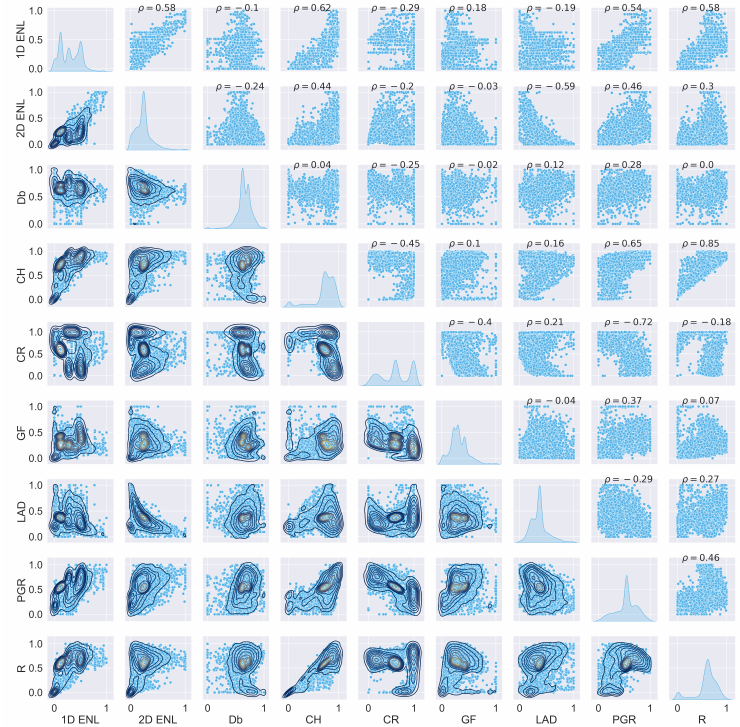
Figure A20. ULS traits plot at 1m grid size.